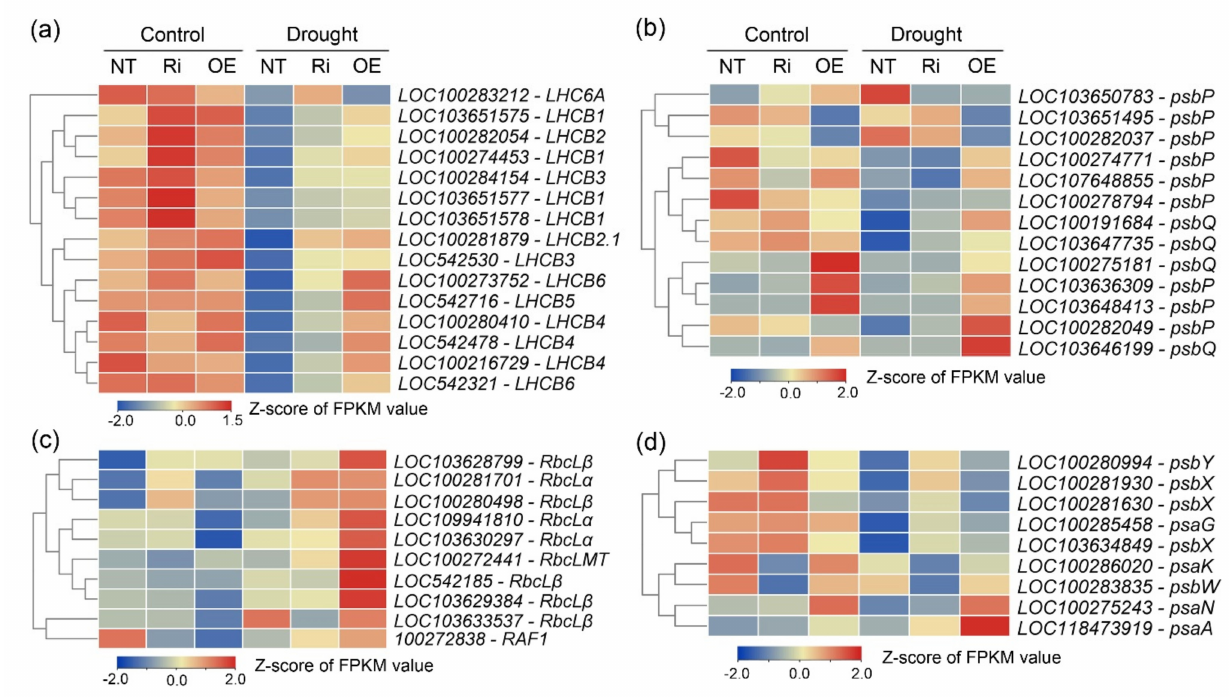
Figure 8. Expression profiles of DEGs involved in the photosynthetic pathway in maize seedlings under drought stress. Heatmaps show the expression level of DEGs. ( a ) Chlorophyll a/b binding protein (LHC); ( b ) PS II oxygen evolving complex (OEC); ( c ) Rubisco large subunit; and ( d ) photosys- tem I and II reaction center proteins. NT, non-transgenic plant; Ri, ZmbHLH -RNAi T 3 maize lines (Ri37); OE, CgbHLH001 -overexpressed T 3 maize lines (OE12). Heatmaps were generated based on the FPKM value (Z-score method). The redder the color, the higher the gene expression level. FPKM, fragments per kilobase of transcript sequence per million fragments